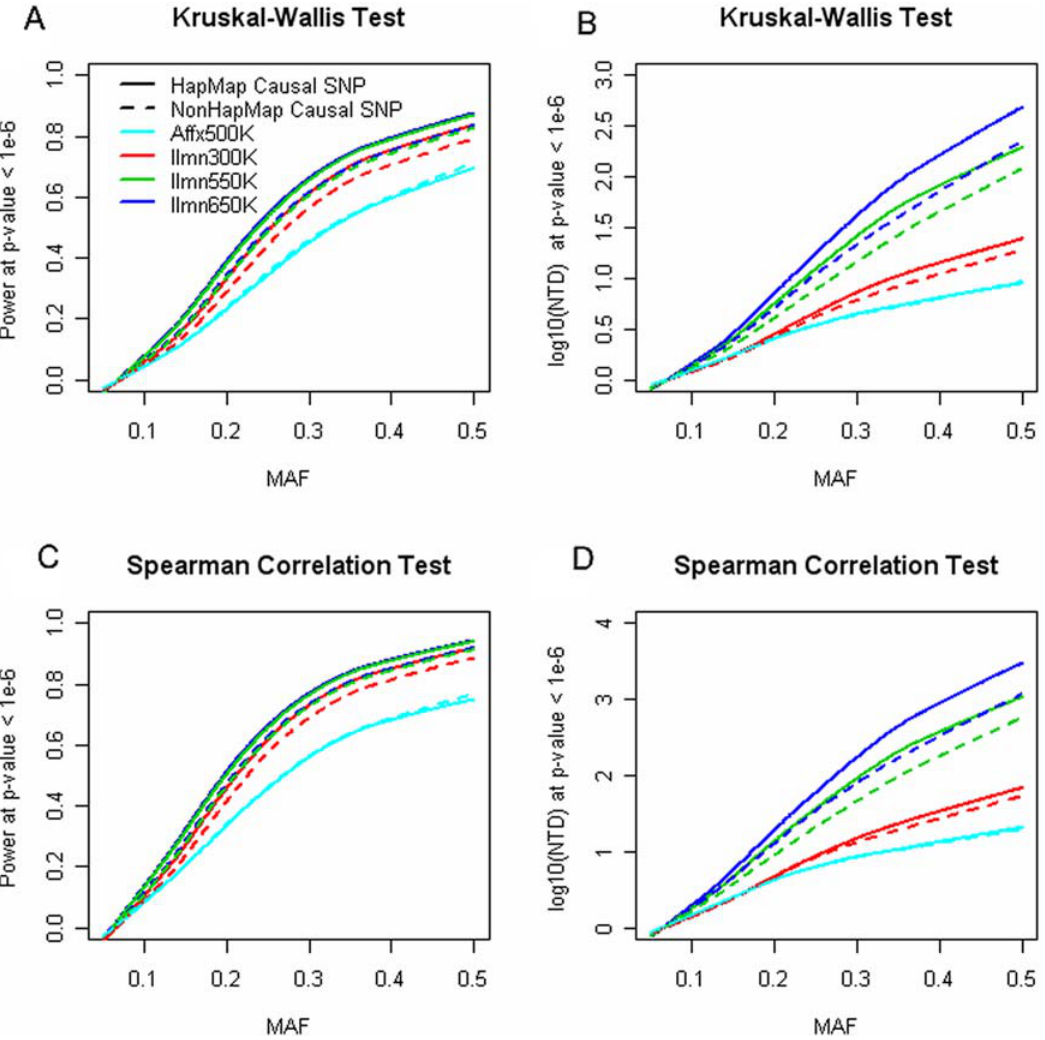
Figure 2. On the simulated trait values, the statistical power and NTD (number of true discoveries) were estimated for the Affymetrix 500K and Illumina tag SNP arrays.